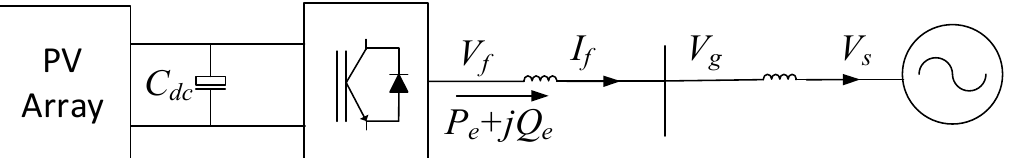
Figure 1. Structure of photovoltaic (PV) power generation system. Legend: C dc , DC filter capacitor; V f , AC side output voltage; V g , voltage of the parallel point with power systems, V s , voltage of the power systems; P e and Q e , the active power and reactive power of PV-VSG.